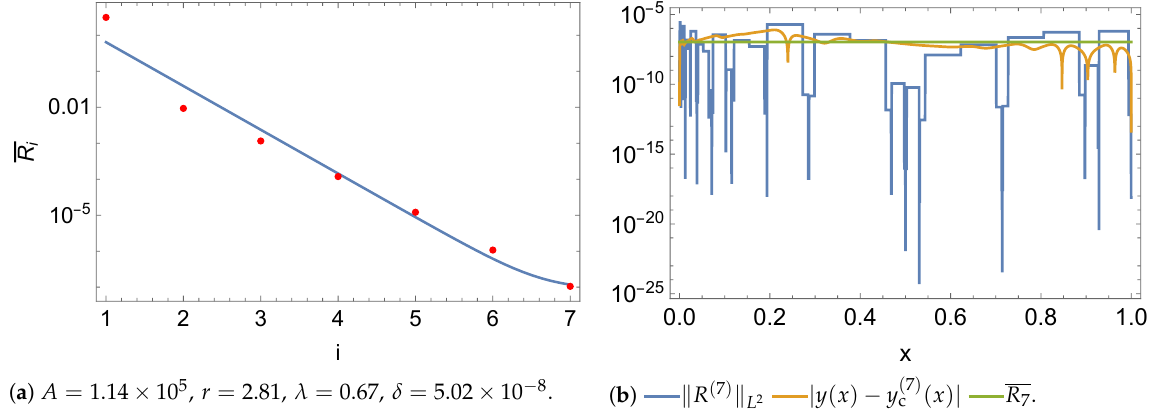
Figure 9. ( a ) Fitting the upper bound (24) with the set R . ( b ) Visualization of the residual, absolute local approximation error, and the mean